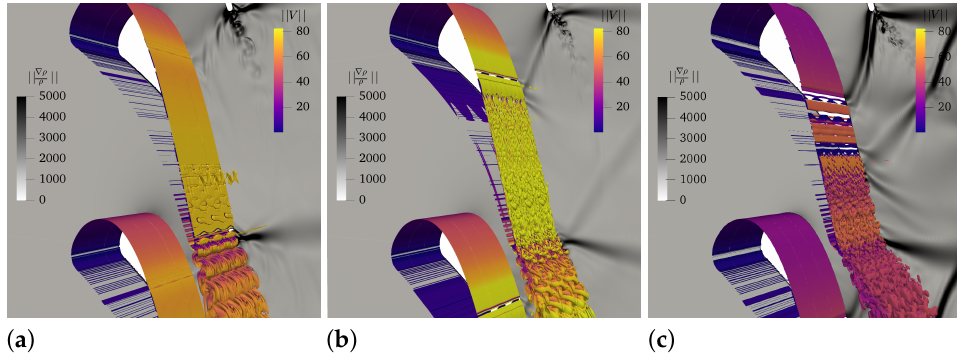
Figure 3. Instantaneous iso-surface of the Q-criterion ( Q = 1000 s − 1 ) colored by the velocity magnitude (m/s), replicated three times in the spanwise direction, and snapshot of the relative density gradient in the background for cases IC1-LPR (low pressure ratio) ( a ), IC1-HPR (high pressure ratio) ( b ), and IC2-LPR ( c